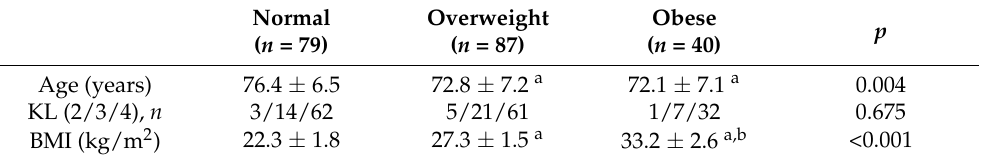
Table 1. Patients’ clinical characteristics by body mass index group. Normal